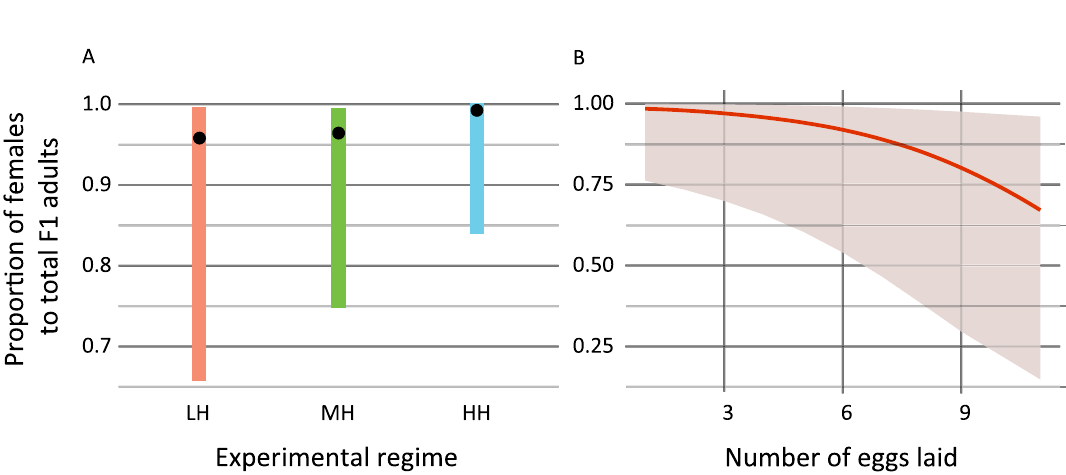
Figure 5. Proportion of females to total adults in the first generation (F1) after dispersal, in relation to ( A ) the level of heterozygosity in the parental population; ( B ) the total number of eggs laid till 4th day after dispersal. Dots ( A ) and line ( B ) represent means, bars ( A ) and shaded area ( B ) denote 95%